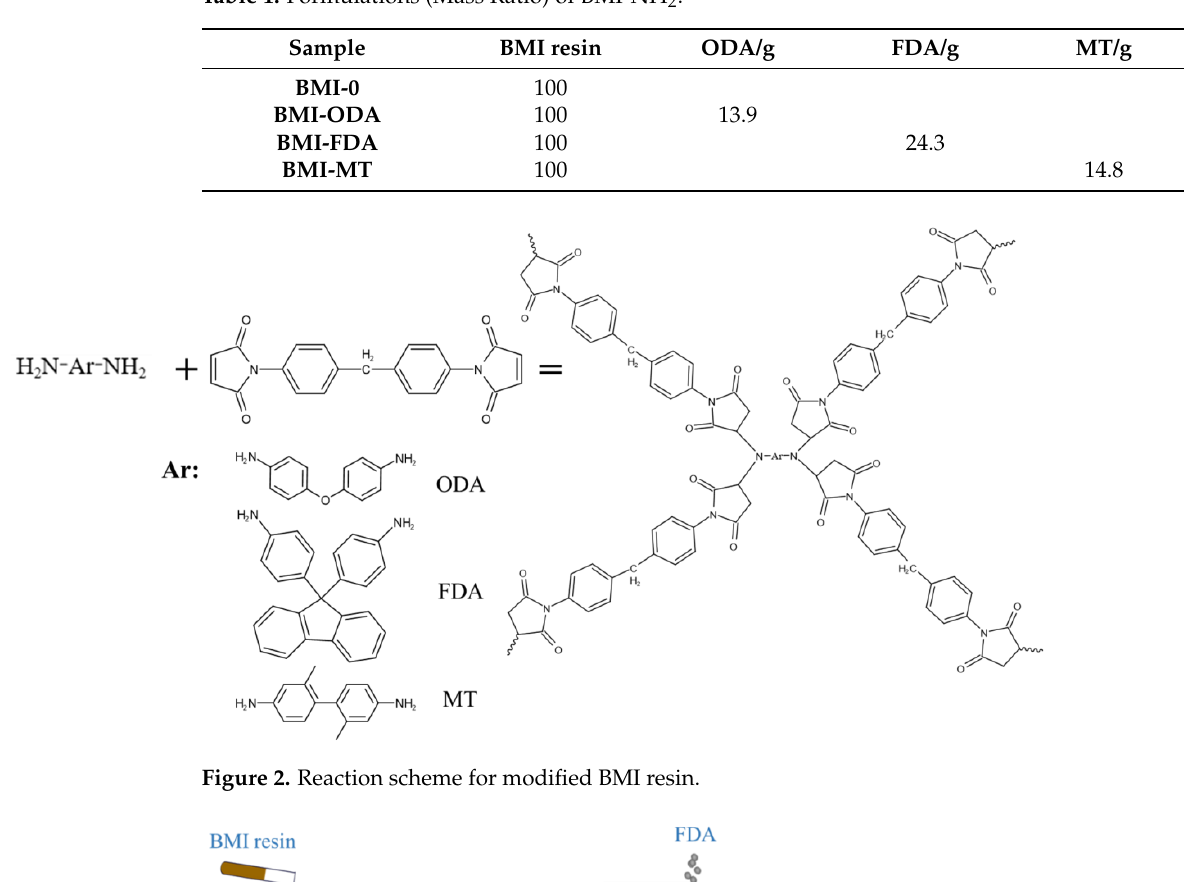
Figure 1. Cured network structure of modified BMI.